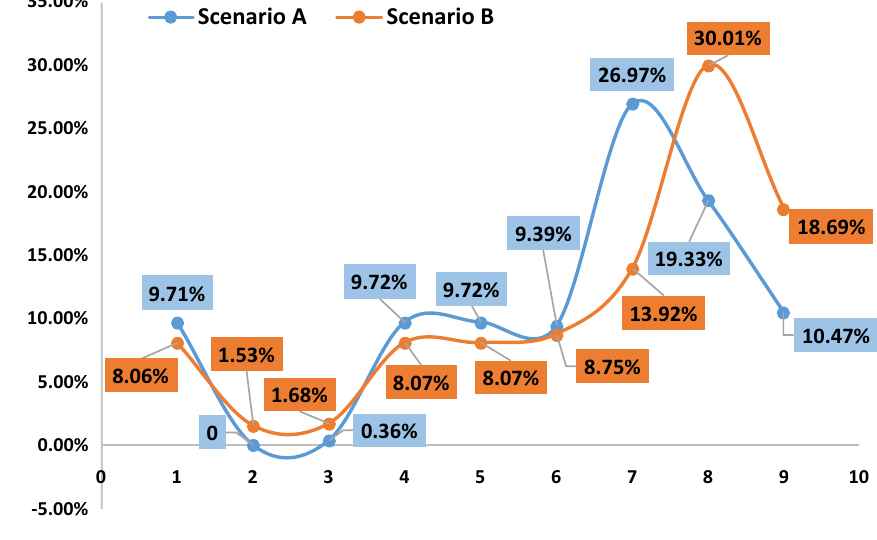
Fig. 6 Proportion variations between former and latter in Scenario A and Scenario